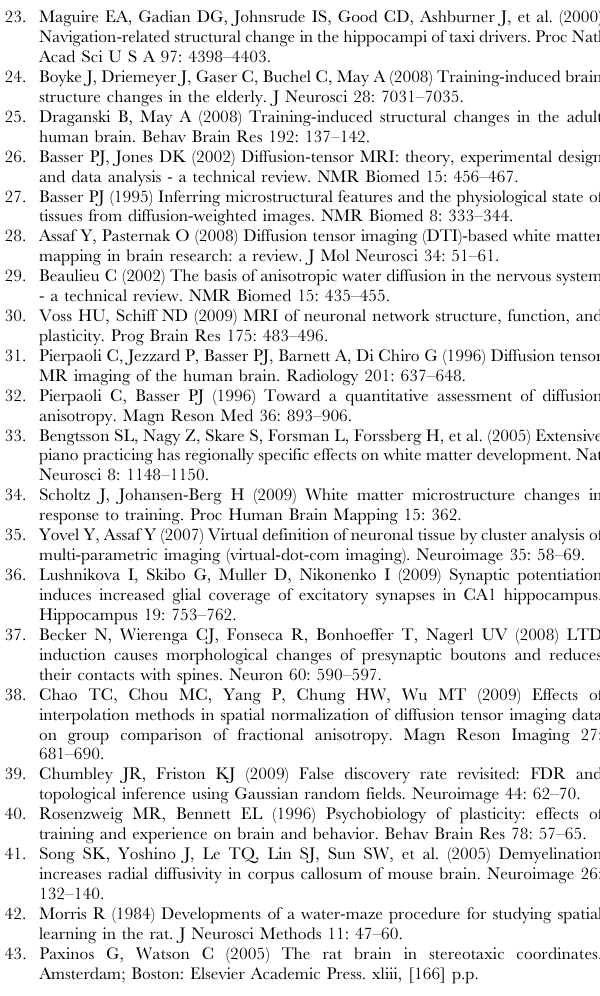
diffusivity maps ( a ), and the VC, cingulate cortex (CG), dorsal hippocampal commissure (DHC), CC, EC, SC, AMG and PC in the radial diffusivity maps ( b ). Figure S3 Histograms of astrocyte area analysis from GFAP staining in the hilus of the hippocampus. Note that after rats were trained in the water maze there was a decrease in the percentage of astrocytes whose area was smalland an increase in the percentage whose area was large. Figure S4 Quality assessment of the registration and normalization procedures. Top row: mean FA of the entire group of rats for a representative slice ( a ), standard deviation map ( b ), and standard deviation divided by the mean ( c ) following registration only between the images. Bottom row: the same information but obtained after